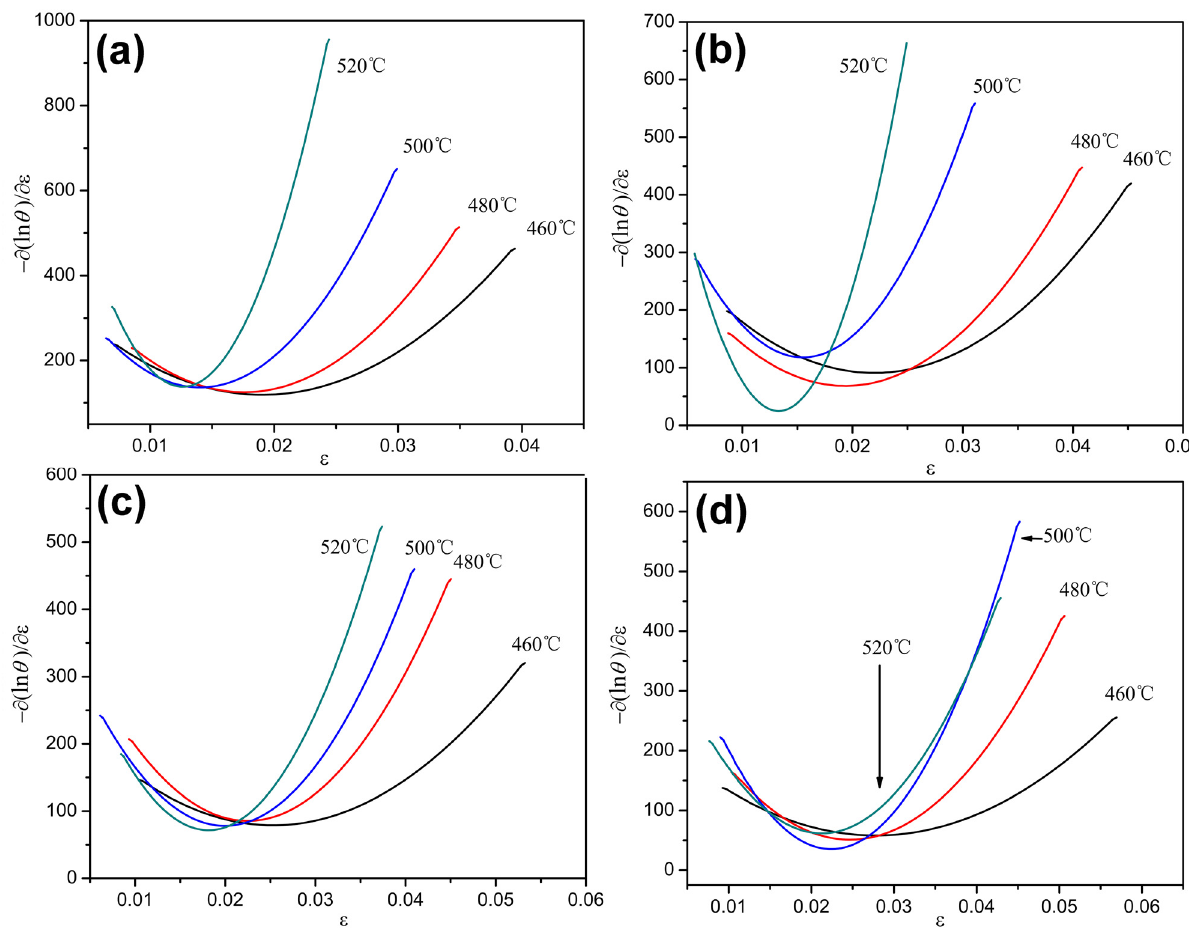
Figure 9: The relationship curves between ( ) / θ ε −∂ ln ∂ and ε under di ff erent deformation conditions: ( a ) ε ̇ = 0.01 s − 1 ; ( b ) ε ̇ = 0.1 s − 1 ; ( c ) ε ̇ = 1 s − 1 ; and ( d ) ε ̇ = 5 s − 1 .